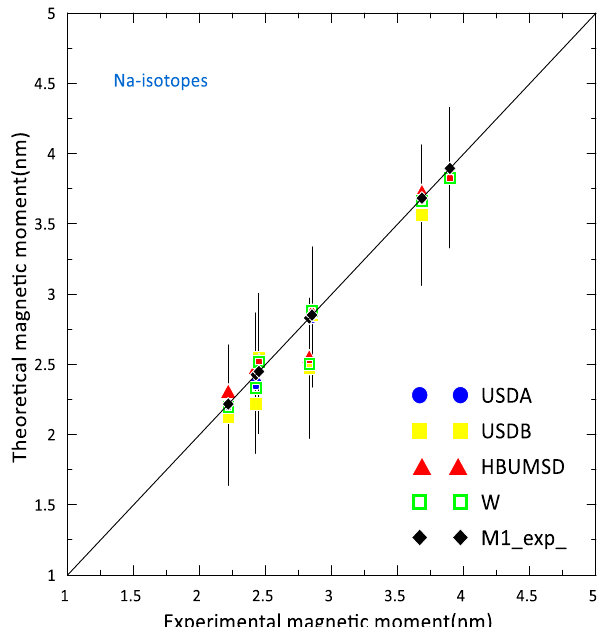
Figure 1: Comparison between theoretical magnetic moments μ (nm) and experimental data [16, 17] for Na-isotopes using two-body effective interactions; USDA, USDB, HBUMSD and W